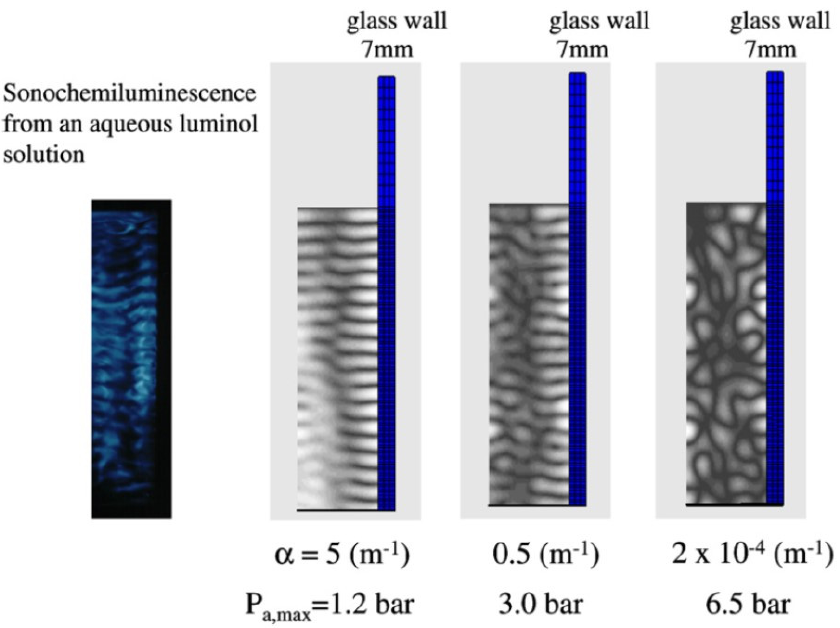
Figure 21. The calculated spatial distribution of the acoustic amplitude for glass wall (7 mm in thickness) for various attenuation coefficients of ultrasound [66]. The full-width at half maximum for the Gaussian distribution of the vibration amplitude of the vibrating plate at the bottom is 5 cm. The wall height is 20 cm. A half of the width (the full width is 7 cm) of the liquid container is shown. The photograph of sonochemiluminescence from an aqueous luminol solution is also shown for the corresponding half plane. Copyright 2007, with the permission from Elsevier.